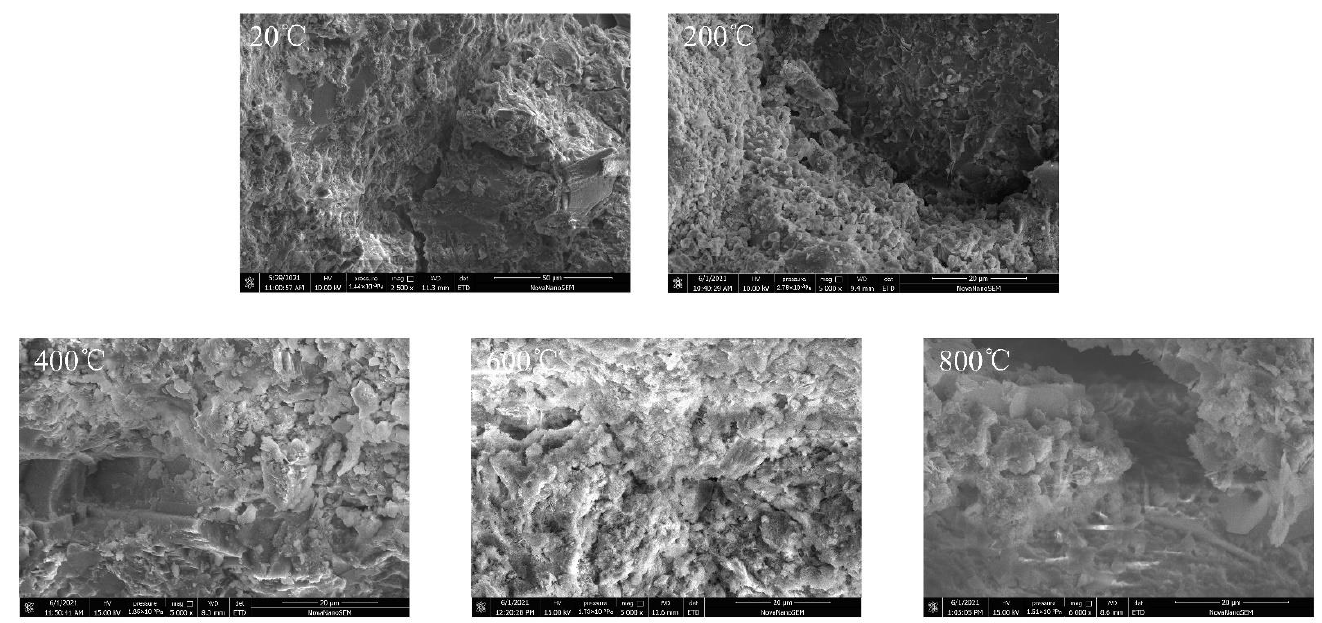
Figure 17. SEM microscopic morphology of concrete after high temperature and rapid cooling.